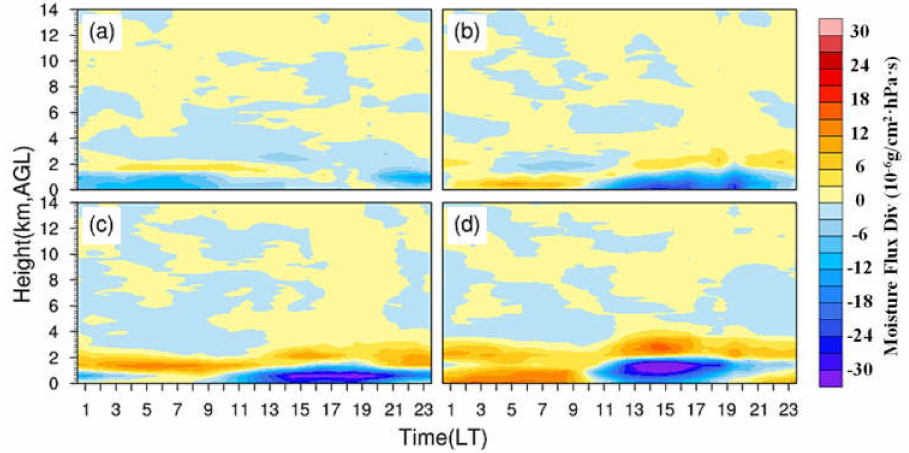
Figure 11. Diurnal variations of moisture flux divergence at four sites, as calculated by ERA5 reanalysis data. The negative values indicate airflow converge, and the positive values indicate airflow divergence. ( a ) GZ; ( b ) LT; ( c ) DC; ( d )